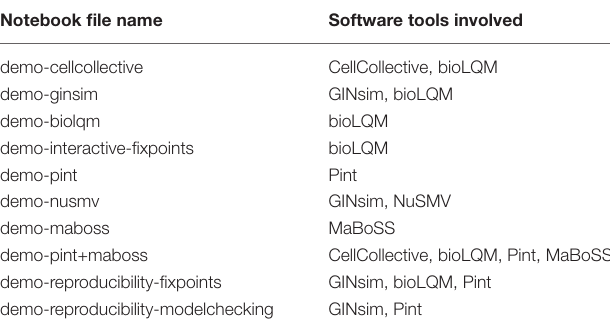
TABLE 2 | List of notebook files in supplemental data "Notebooks" ( Data Sheet 2 ) demonstrating some features of the CoLoMoTo Interactive